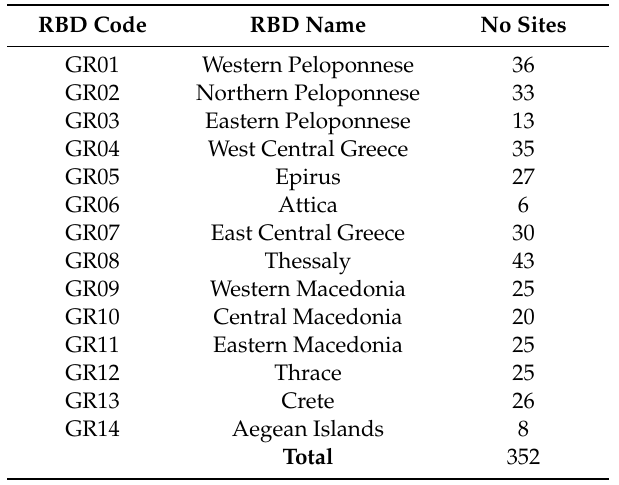
Table 1. Distribution of sampling sites per River Basin Districts